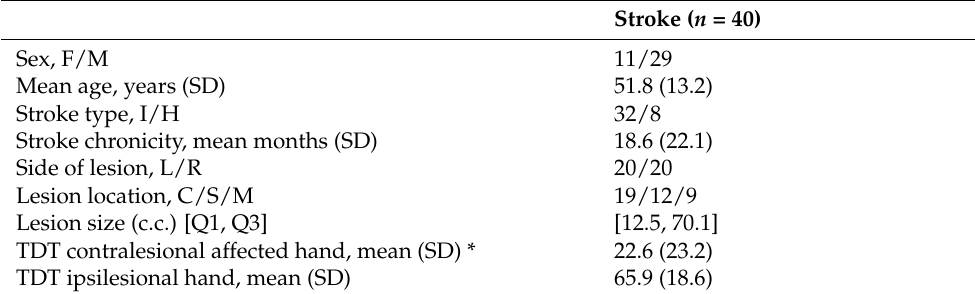
Table 1. Demographics of the